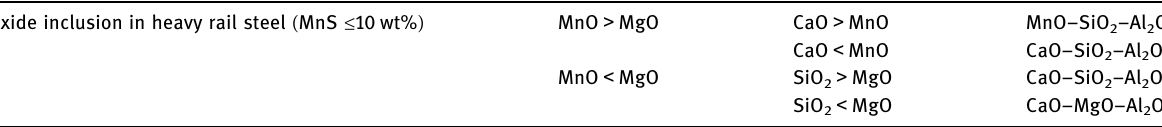
Table 2: Standard for classi fi cation of oxide inclusions in heavy rail steel